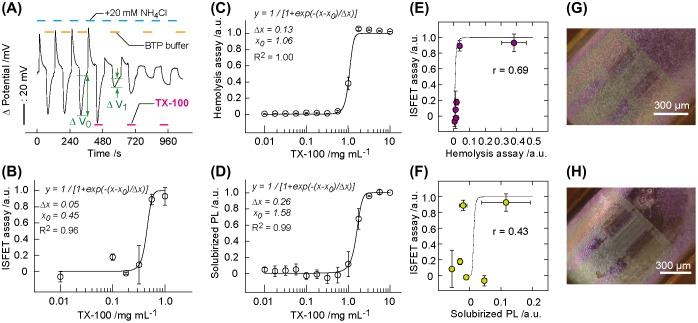
A decrease in pH is correlated to plasma membrane damage. (A) Changes in the ISFET signal (1 − ΔV/ΔV
0) of the ISFET assay was used as a parameter for membrane injury. ΔV was obtained after exposing the cells to TX-100 at desired concentrations for 60 s. (B) The ISFET signal after exposing the cells to TX-100 at desired concentration for 60 s. The solid line and equation represent the curve fitting result using the logistic function. Data are presented as mean ± standard deviation (n = 3). (C, D) The degree of hemolysis (C) and solubilized phospholipid (PL) (D) of sheep erythrocytes after incubating in TX-100 for 20 min (n = 3). (E, F) The scattered plot showing the correlation between the ISFET signal and the degree of hemolysis (E) and between the ISFET signal and the degree of solubilized PL (F) for TX-100 exposure to the cells. The solid line shows the standard curve obtained by the logistic function for each assay. Correlation coefficients: r = 0.69 (E) and 0.43 (F). Data are represented as mean ± standard deviation (n = 3). (G, H) BF micrographs of the cells on ISFET after treated with 0.0 mg ml−1 (G) or 1.0 mg ml−1 (H) TX-100.